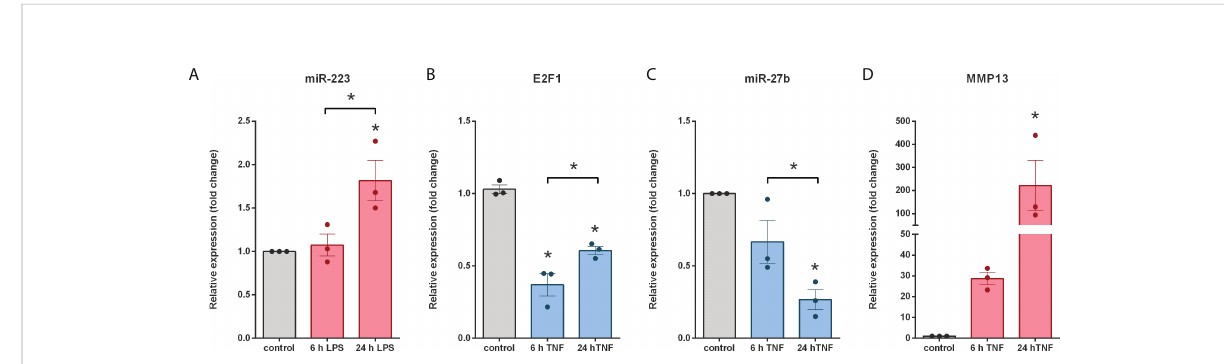
FIGURE 8 Coherent expression changes of miRNAs, miRNA targets and regulating transcription factors in LPS treated THP-1 cells and TNF a triggered HT- 29 colonic epithelial cells. Relative expression of miR-223 (A) in LPS treated THP-1 cells, and E2F1 (B) , miR-27b (C) and MMP13 (D) in TNF a activated HT-29 cells. Data are presented as the mean ± SEM (n=3);* p